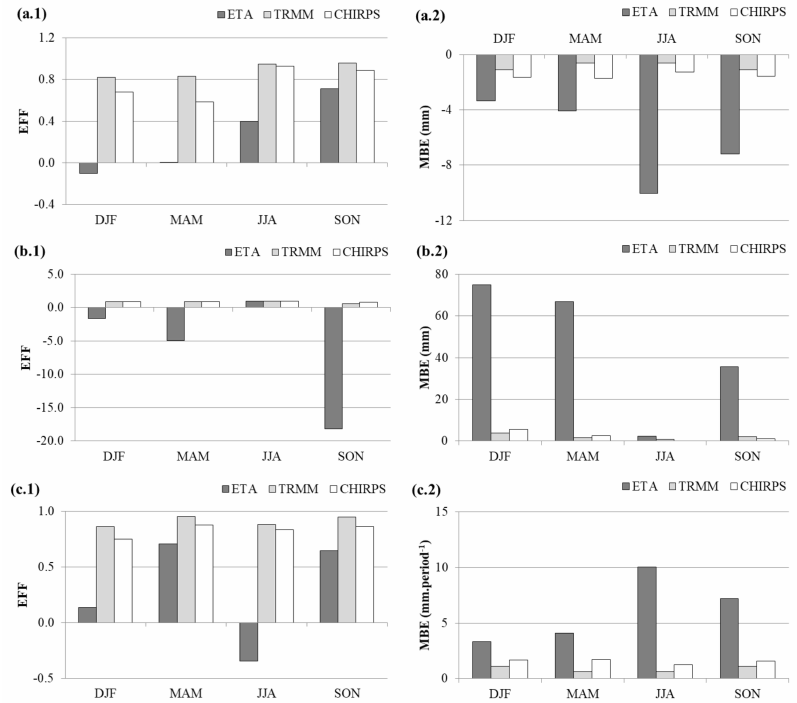
Figure 8. (a.1, b.1, c.1) Nash-Sutcliffe efficiency coefficient (EFF) and (a.2, b.2, c.2) average of errors (MBE), for the periods (DJF, MAN, JJA, and SON), determined for ( a ) water deficit, ( b ) water surplus, and ( c )